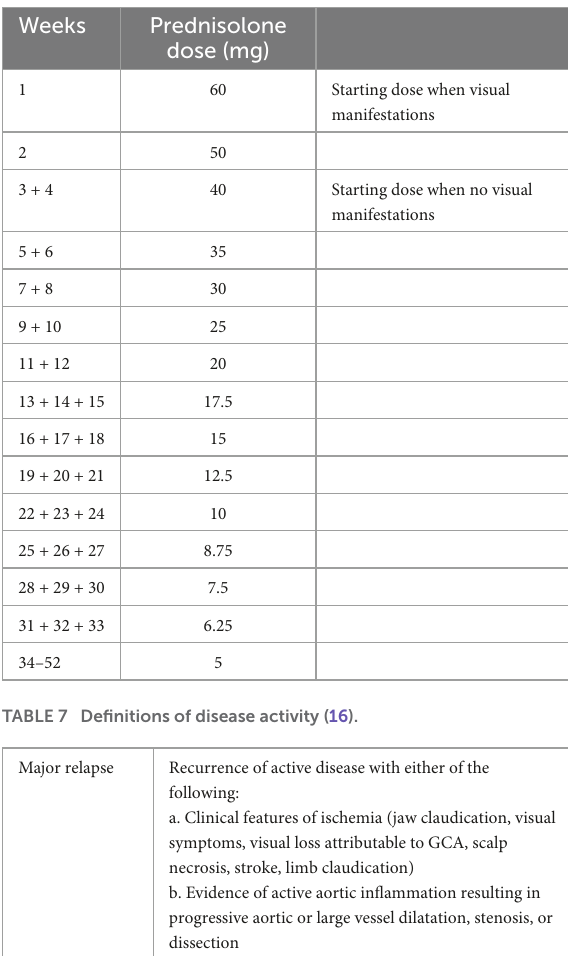
TABLE 6 Prednisolone tapering.